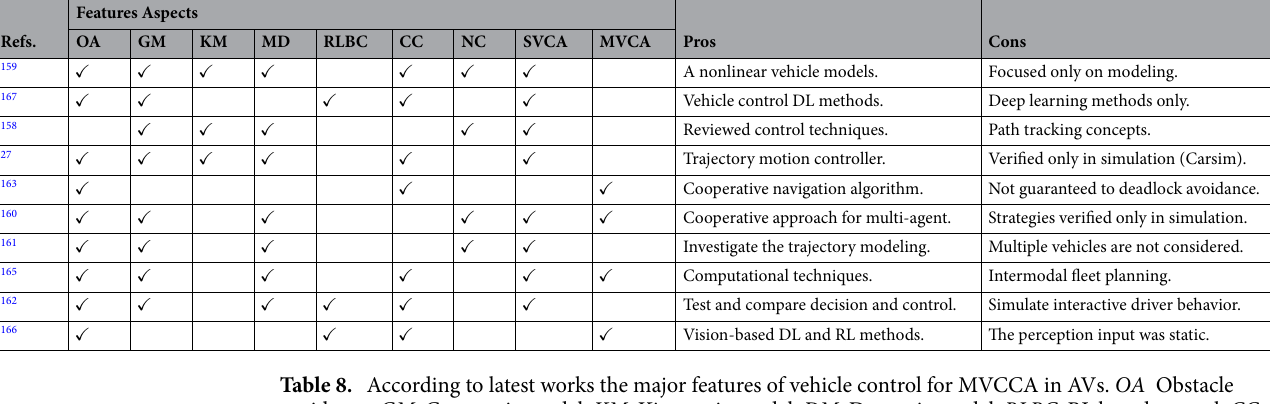
A nonlinear vehicle models. Focused only on modeling.